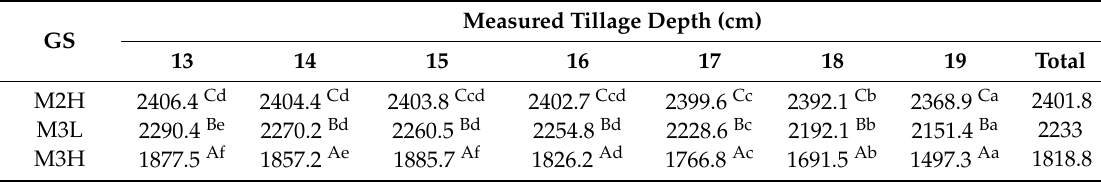
Figure 8. Overall engine load according to tillage depth and gear selection. Table 8. Mean engine rotational speed (rpm) according to tillage depth and gear selection (GS). Table 7. Mean engine torque (Nm) according to the tillage depth and gear selection (GS).